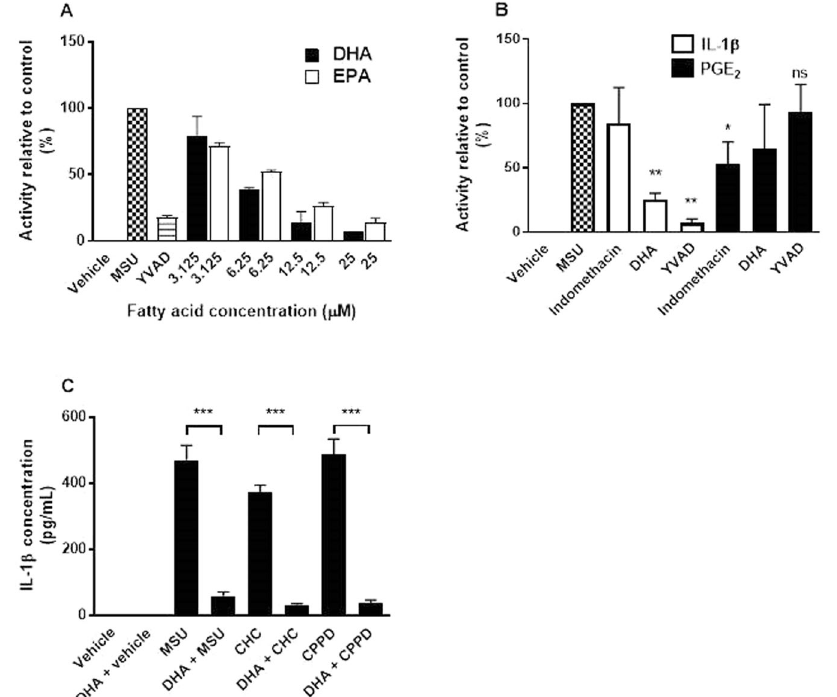
Figure 1. In vitro cell-based activity of long-chain omega-3 DHA and EPA in crystal-mediated inflammation. ( A ) Dose titration of DHA and EPA in THP-1 macrophages (n = 2) alongside YVAD, MSU and vehicle control treatments (n = 8). ( B ) MSU checked bar indicates maximal induction of either IL-1 β or PGE 2 from the same experiment; DHA (20 µ M) and YVAD (10 µ M) preferentially blocked MSU-induced IL-1 β , and indomethacin preferentially blocked PGE 2 . ( C ) In human PBMCs, DHA (20 µ M) was used to block IL-1 β production induced by 0.2 mg/mL of MSU, 5 mg/mL of CHC and 5 mg/mL of CPPD crystals. Error bars indicate the standard error of the mean. THP-1 data from three independent experiments and PBMC data from five individual donors. * P < 0.05, ** P < 0.01, *** P < 0.001 versus crystal using t -tests. ns, not significant versus MSU. CHC: cholesterol; CPPD: calcium pyrophosphate; DHA: docosahexaenoic acid; EPA: eicosapentaenoic acid; IL-1 β : interleukin-1 β ; MSU: monosodium urate; PBMC: peripheral blood mononuclear cell; PGE 2 : prostaglandin E 2